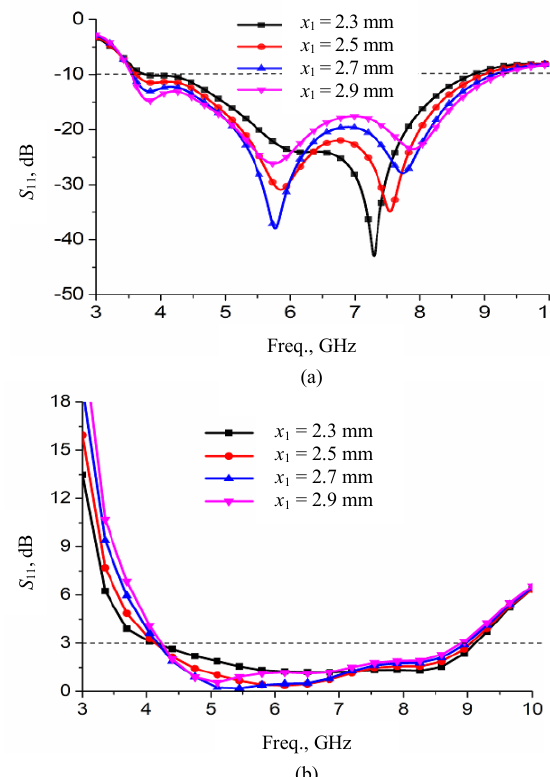
Fig. 6. Effect of ‘ x 1 ’ on impedance bandwidth and axial ratio.